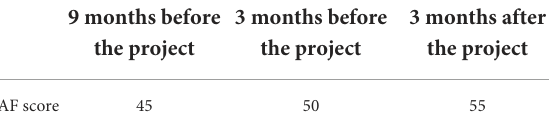
TABLE 3 Change of score on the